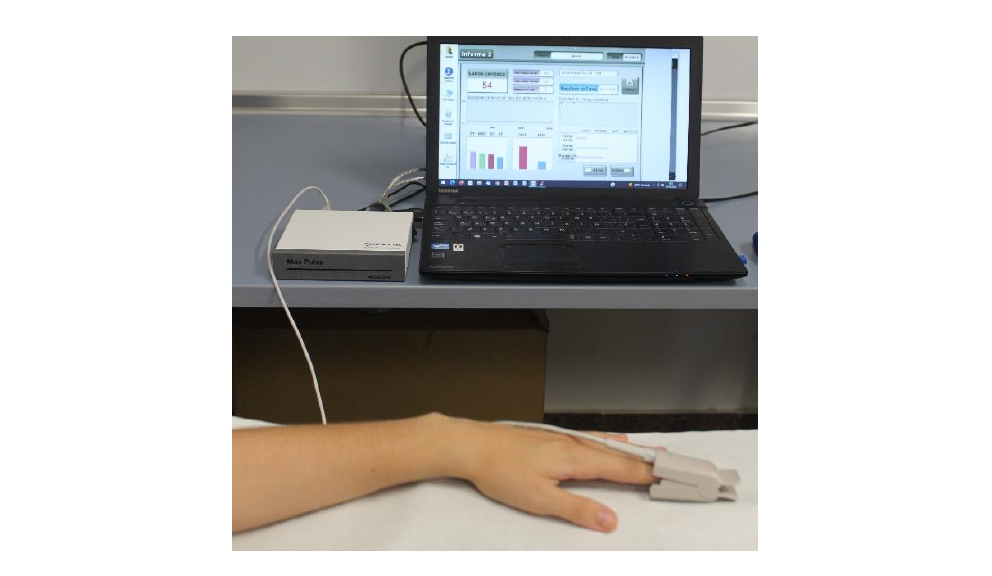
Figure 1. Max Pulse digital sensor and device.